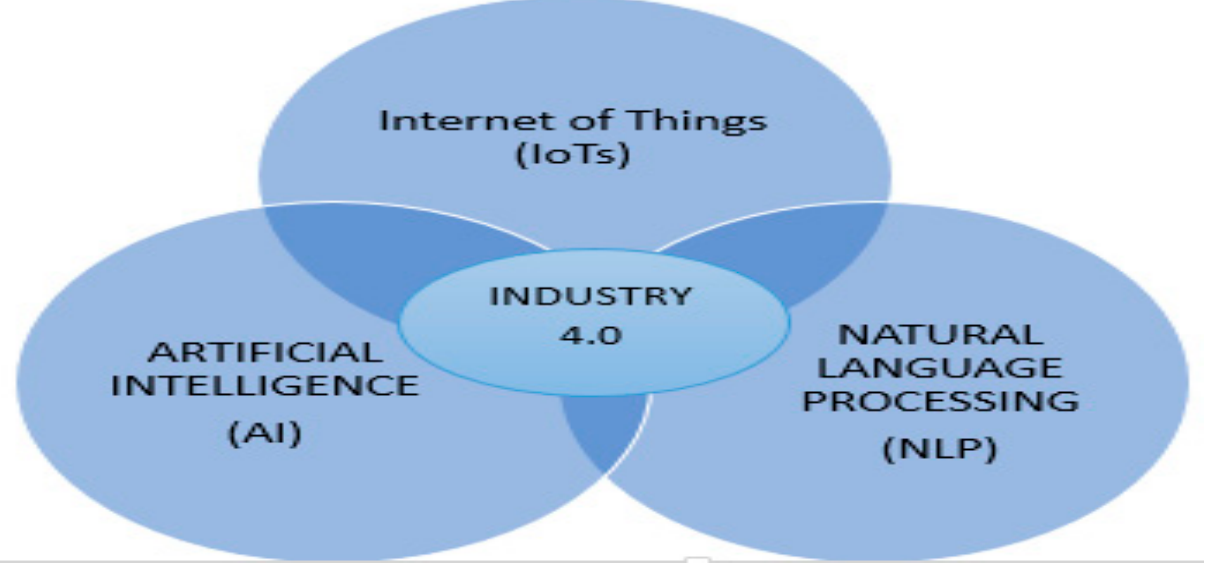
Figure 8. Correlation of NLP, AI, and IoTs.